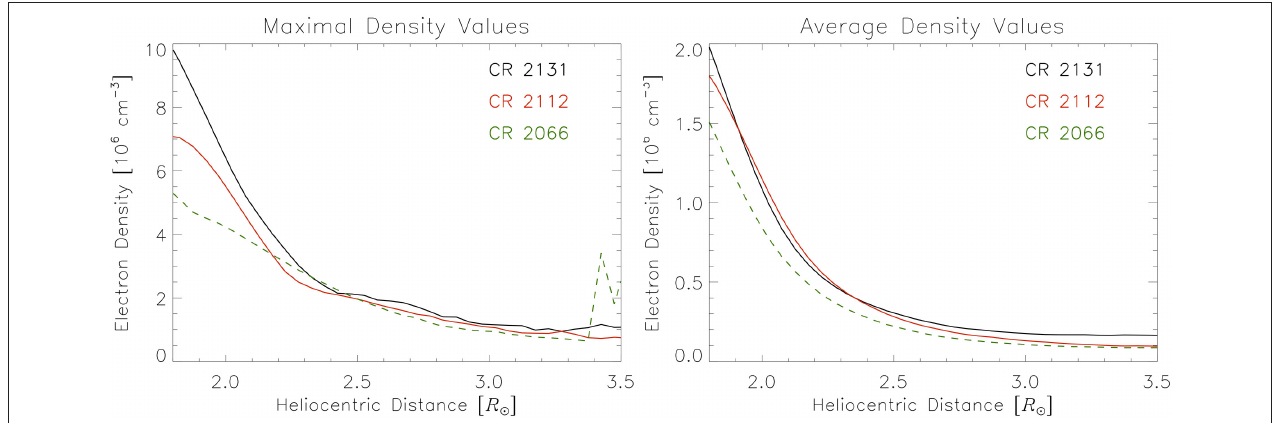
FIGURE 5 | Maximal (left panel) and average over a spherical surface area (right panel) electron density values at different heliocentric distances for CR 2066 (dashed green), 2112 (solid red), and 2131 (solid black). CR 2066 corresponds to deep solar minimum, while CR 2131 corresponds to period near solar maximum.